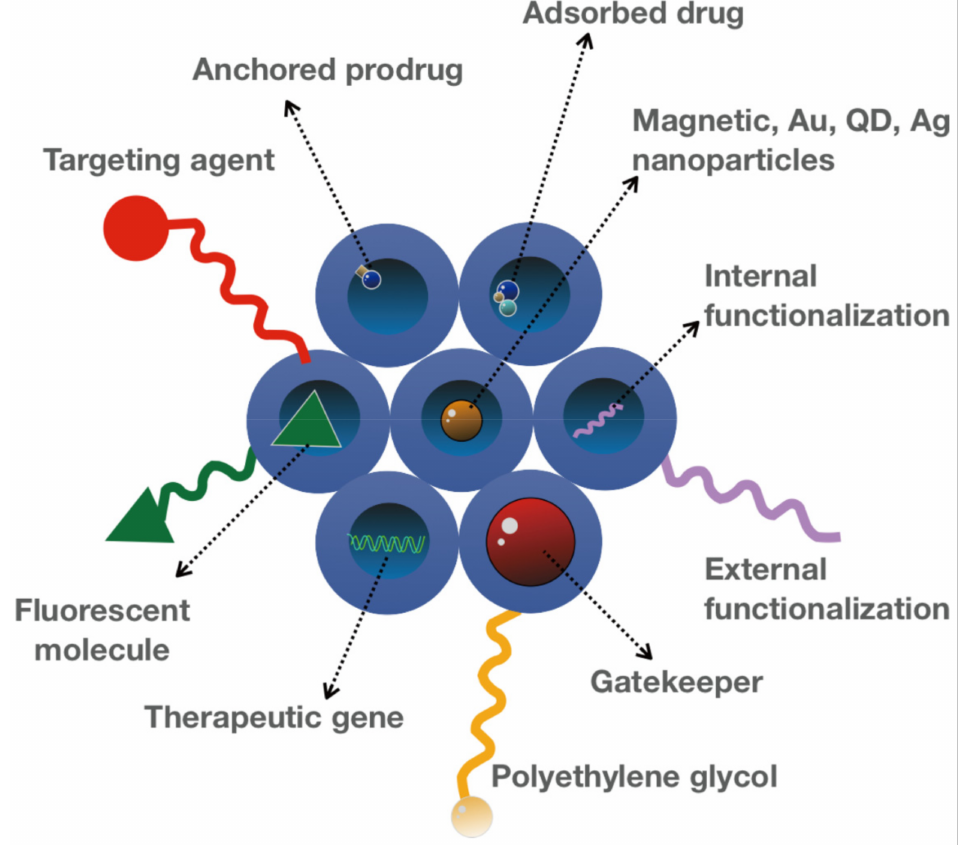
Figure 3. Functionalization of MSNs. MSN pores with different surface modifications allow the con- struction of smart MSNs with controlled drug delivery and release, required for various therapeutic and diagnostic